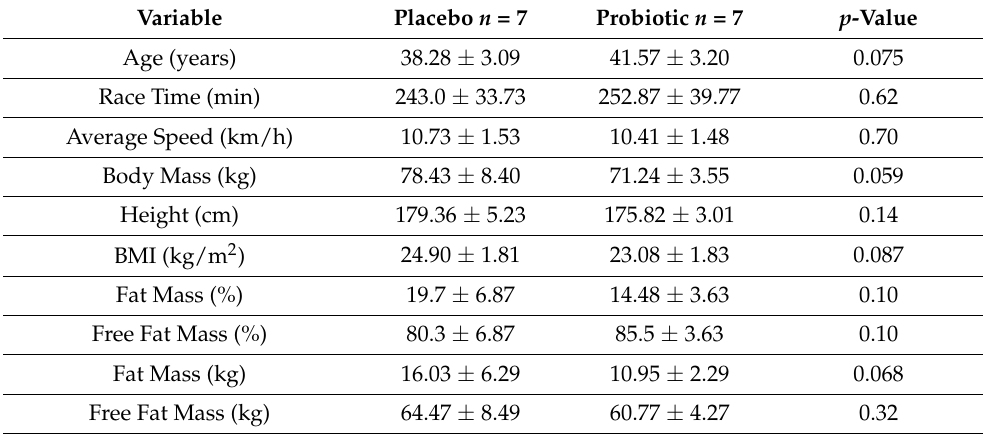
Table 2. Subjects’ characteristics.